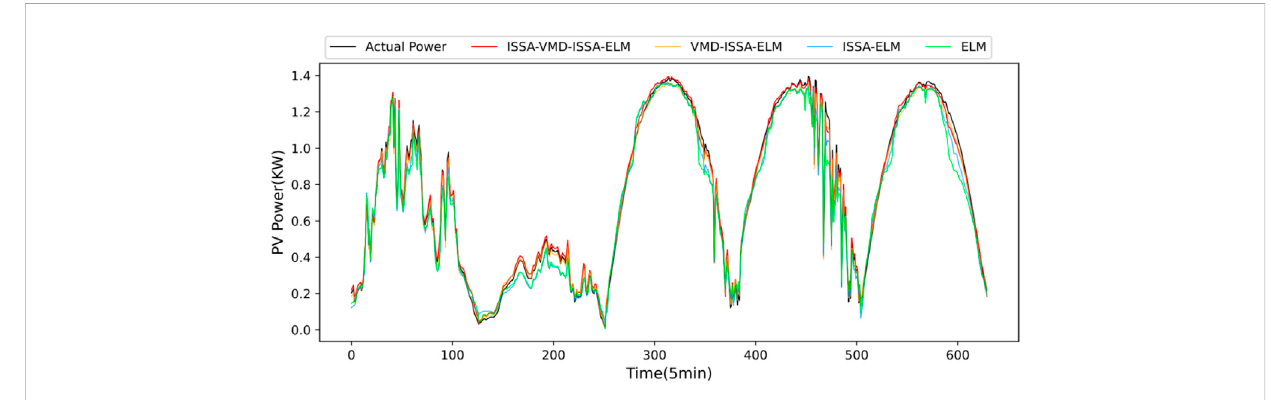
FIGURE 17 Forecast results of different models for 5 consecutive days.